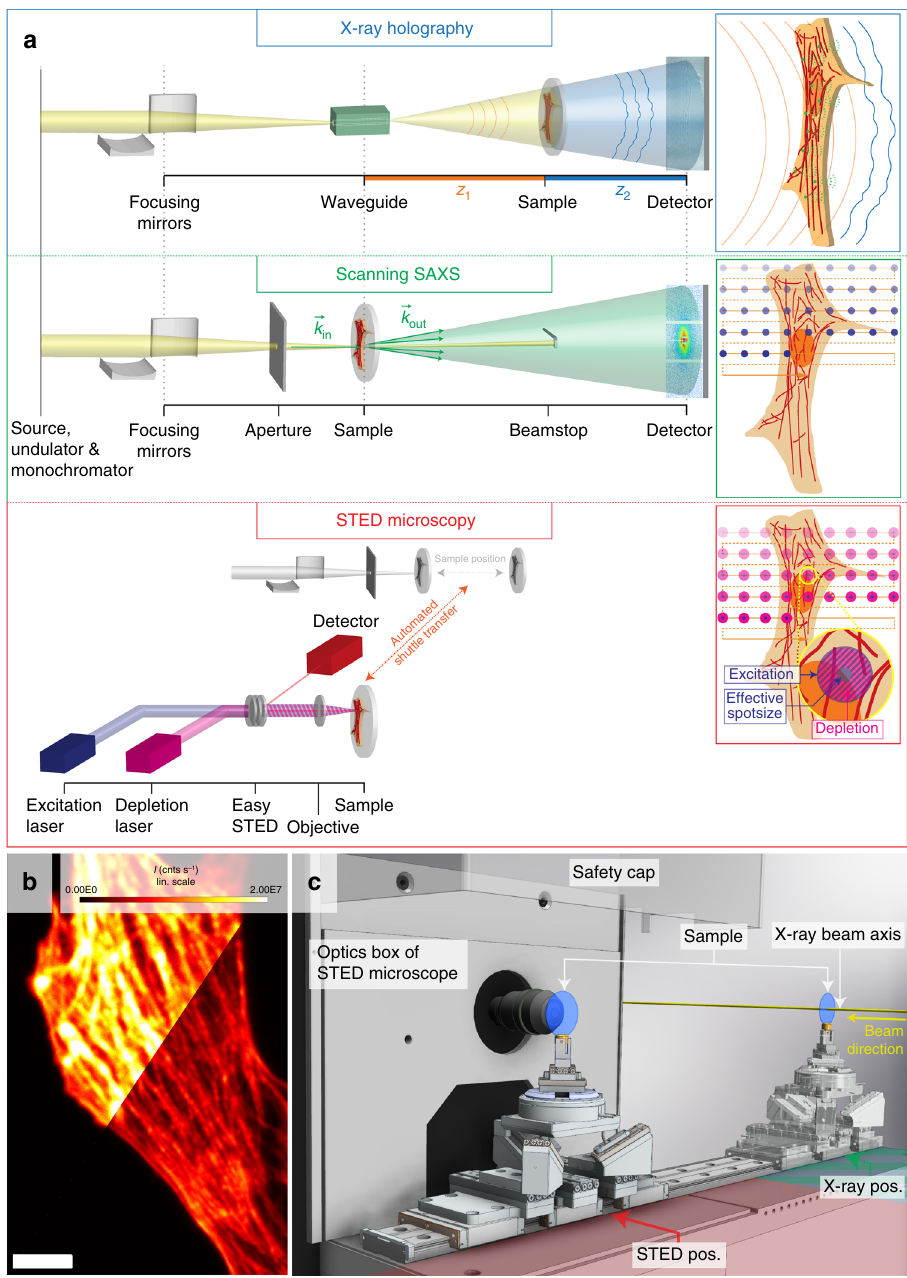
Fig. 1 Recording schemes and instrumental realization at the beamline. a Schematic of the three imaging modalities: X-ray holography (top), scanning SAXS with nano-focused X-rays (center) and in situ STED microscopy (bottom). b Confocal (top left) and STED-image (lower right) of a cardiac tissue cell with labeled actin cytoskeleton. Scale bar: 5 μ m. c 3D illustration of the sample in the STED (red) or the X-ray recording position (blue/green),